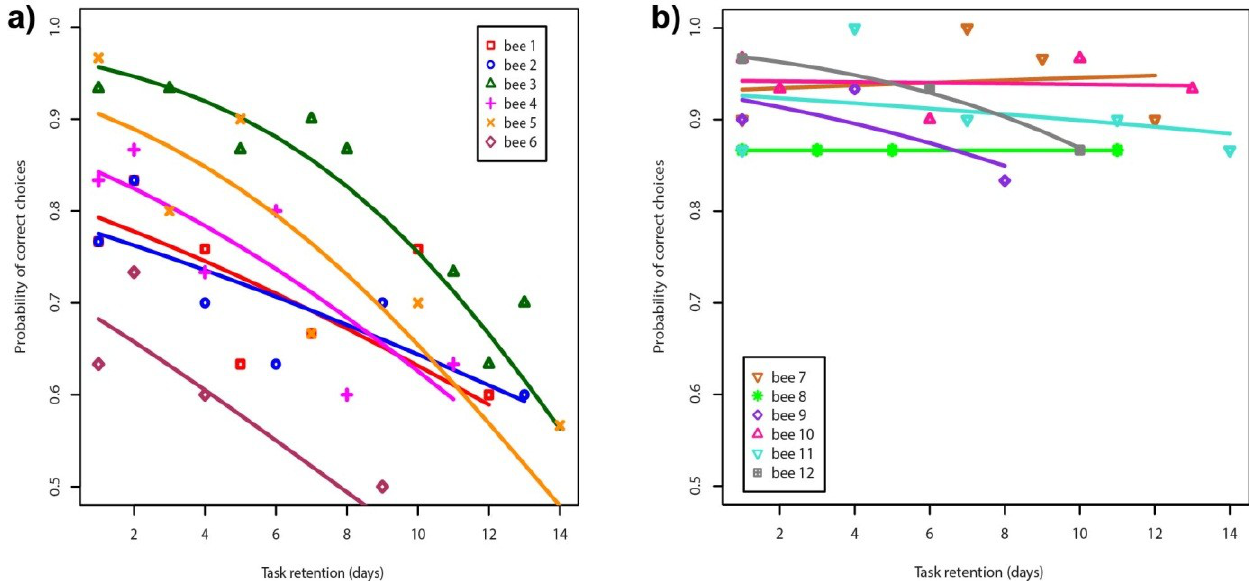
Figure 2. Probability of correct choices for a total of 12 bees performing a hard colour discrimination task (panel a , n = 6) and an easy discrimination task (panel b , n = 6) tested on different days during two weeks. Solid lines represent a logistic regression model fitted to the data corresponding to each individual